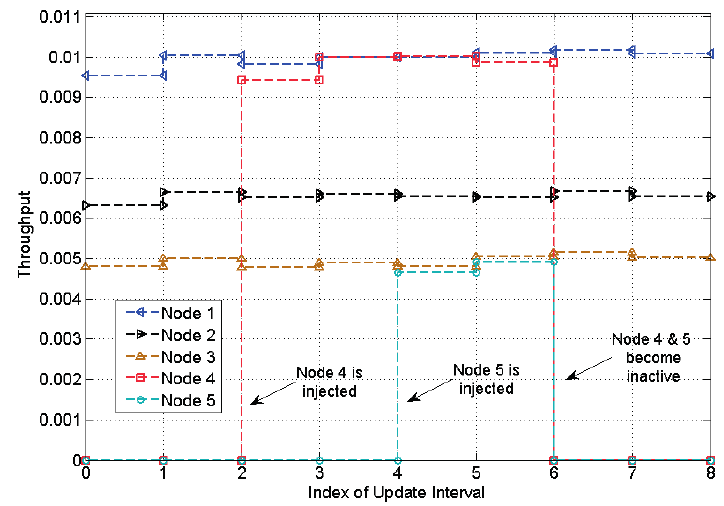
Figure 9. Actual throughput in a heterogeneous network with changes on the number of